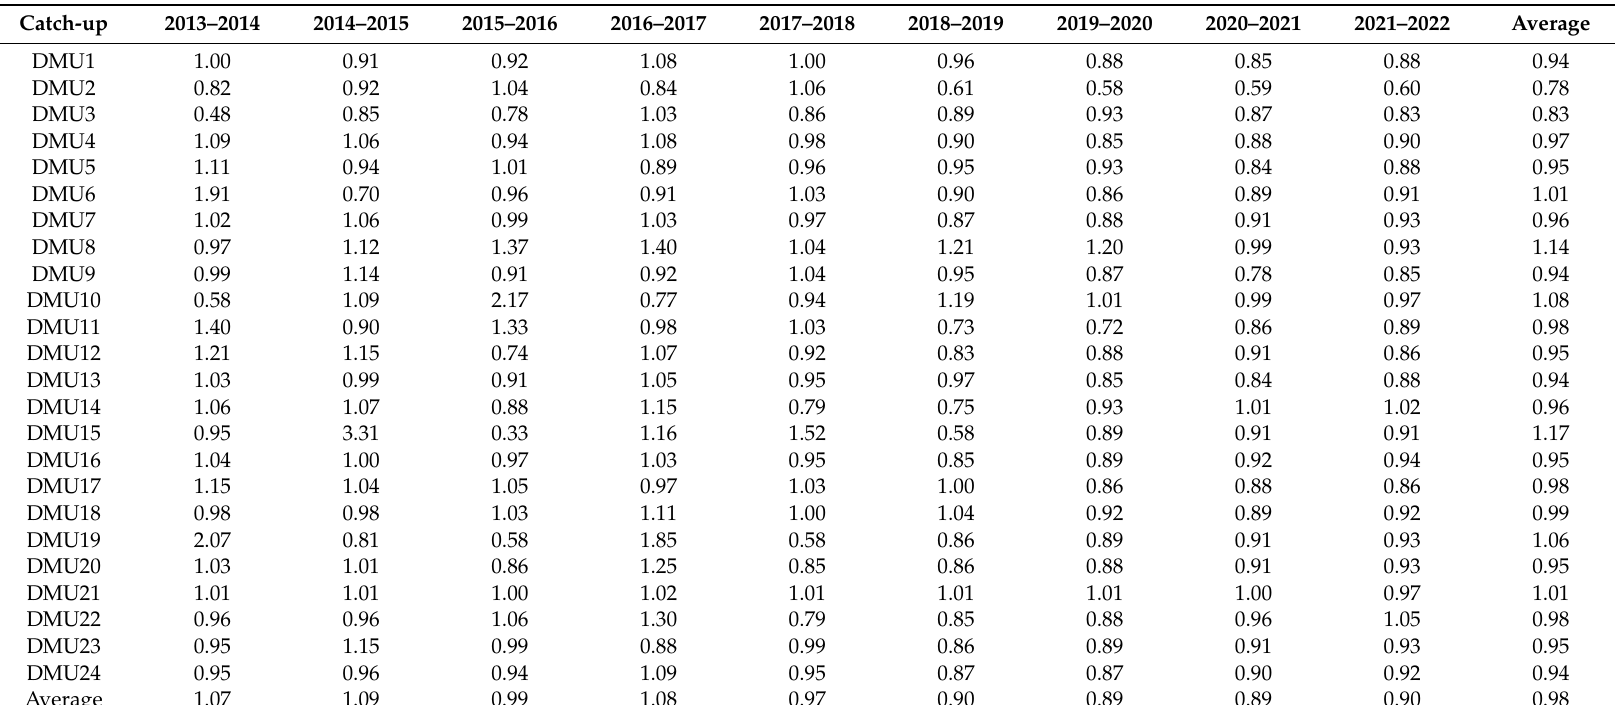
Table 6. The Catch-up e ffi ciency